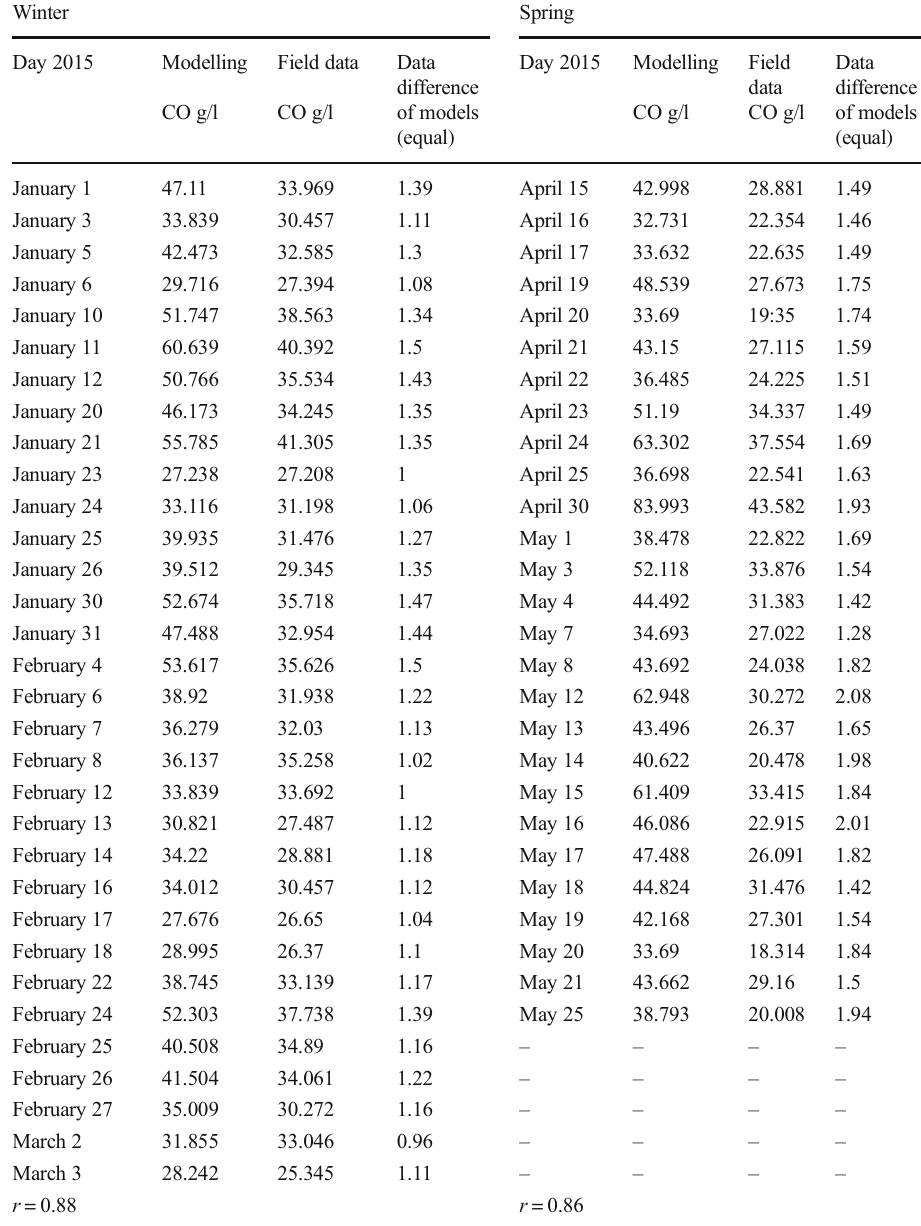
Table 3 Comparison of CO emissions concentration of the model and Field